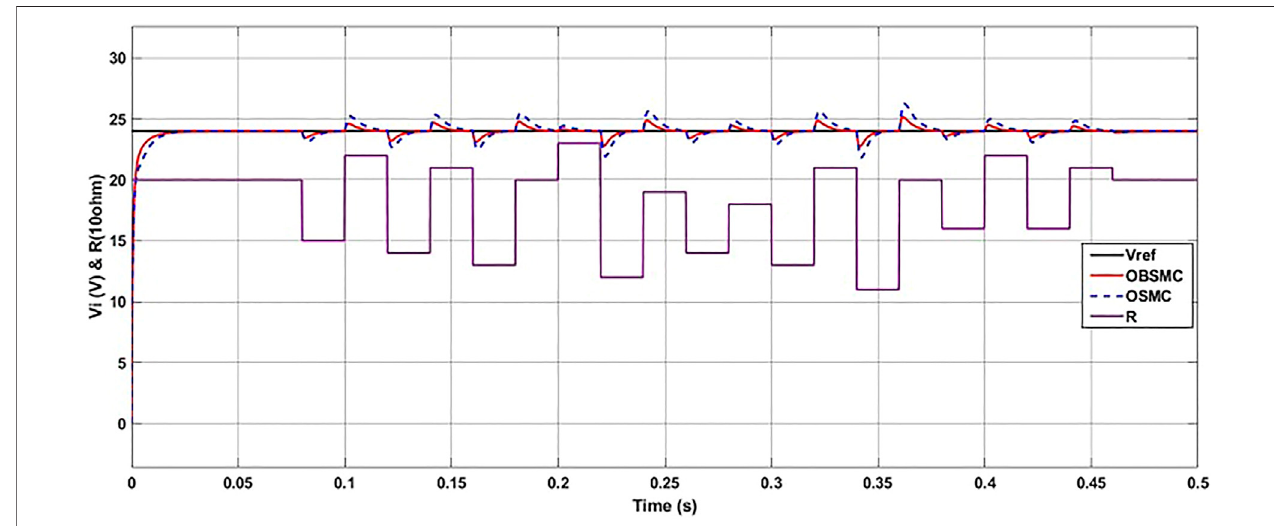
FIGURE 10 | Output voltage of the converter for load resistance variation R .